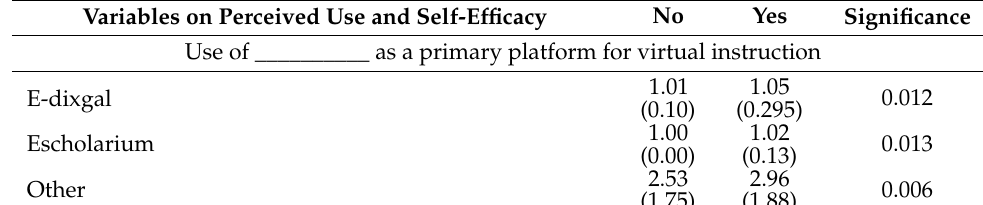
Table 3. Student’s t -test based on whether or not they received